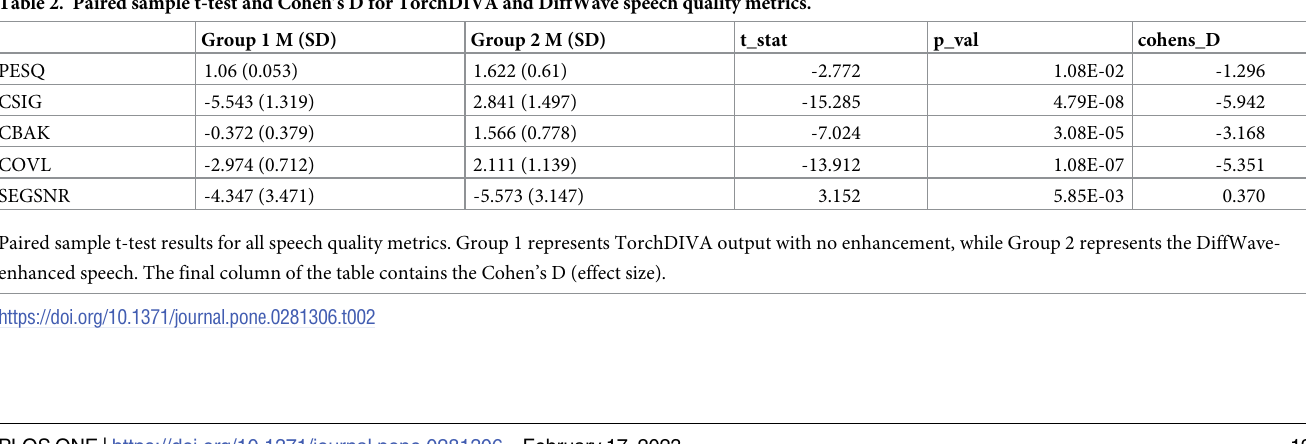
Table 2. Paired sample t-test and Cohen’s D for TorchDIVA and DiffWave speech quality metrics. Group 1 M (SD) Group 2 M (SD) t_stat p_val cohens_D PESQ 1.06 (0.053) 1.622 (0.61) -2.772